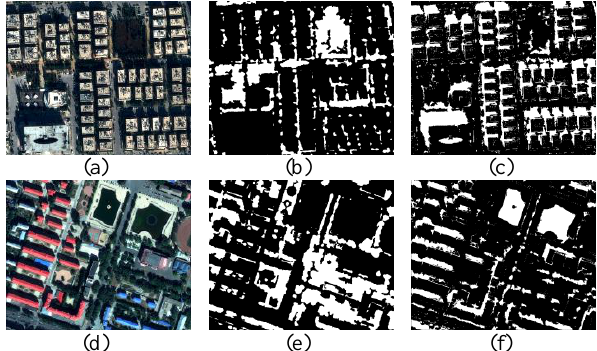
Figure 1. (a, d) Geoeye-1 pan-sharped images (RGB), the (b, e) vegetation masks ( M V ), and (c, f) shadow masks ( M S